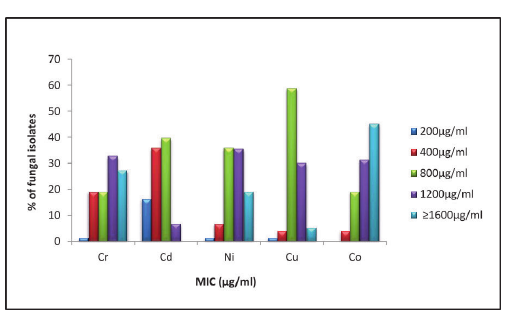
Fig. 3. Heavy metal tolerance level among 73 soil fungal isolates. Table 6. Minimum inhibitory concentration (MIC) of heavy metals against different isolates of Aspergillus MIC ( µ g ml -1 ) Number of Aspergillus